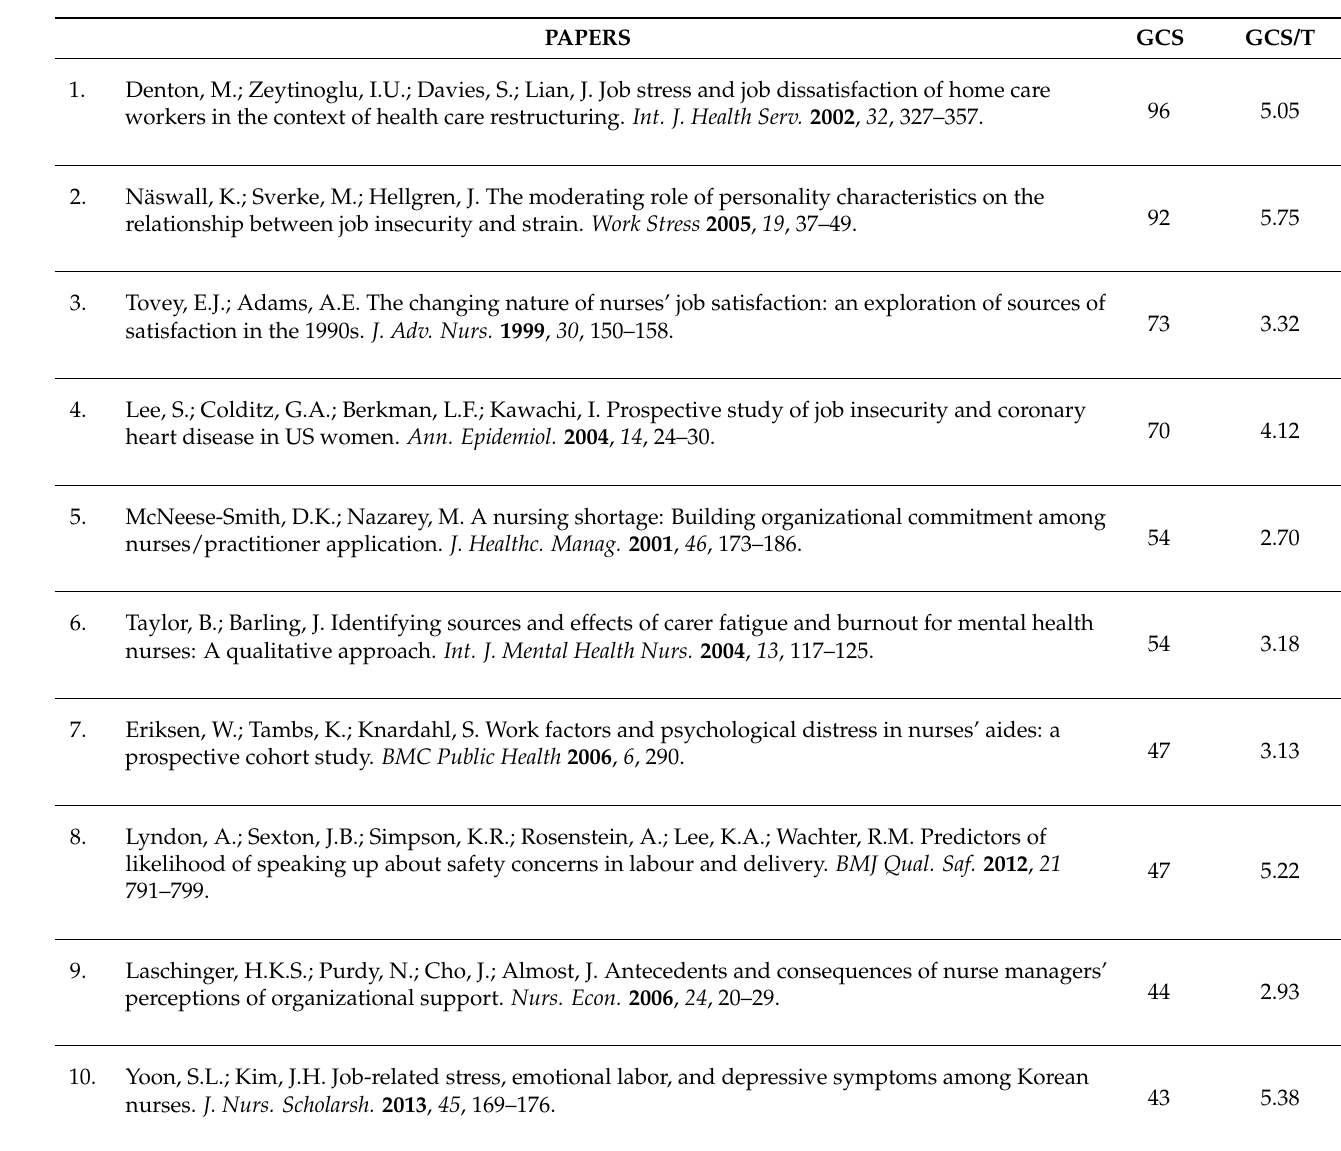
Table 2. The 10 most cited papers (GCS ≥